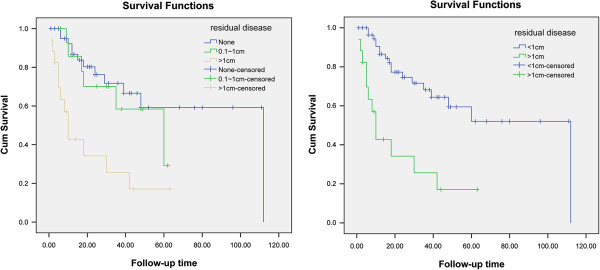
Survival curve of residual disease after second debulking surgery.